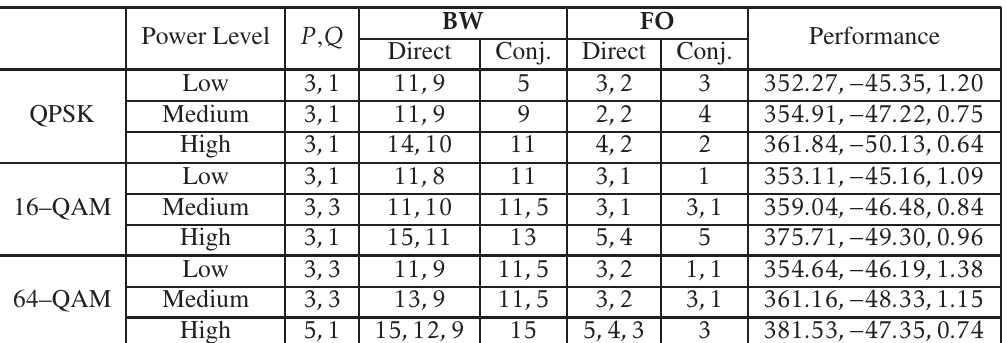
Table 1. Selected Pareto-optimized parameter settings for LTE under different modulations. The design evaluation metrics are shown in the format ( P , ACPR , EVM ) with units (mW, dBc, FIR